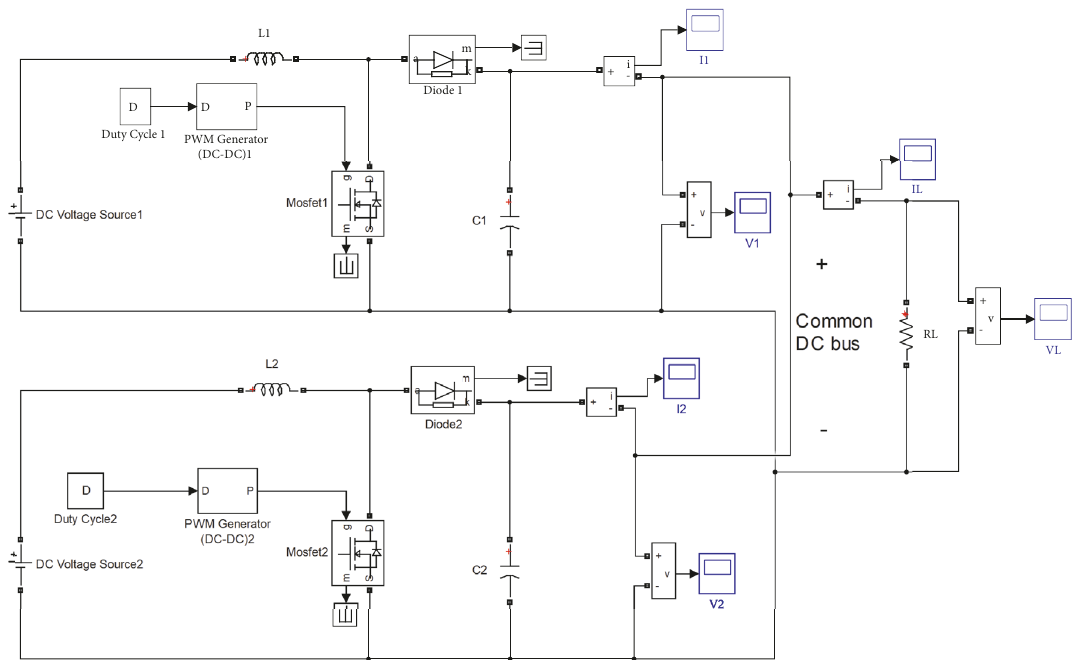
Figure 8: Schematic diagram of the two boost parallel-connected